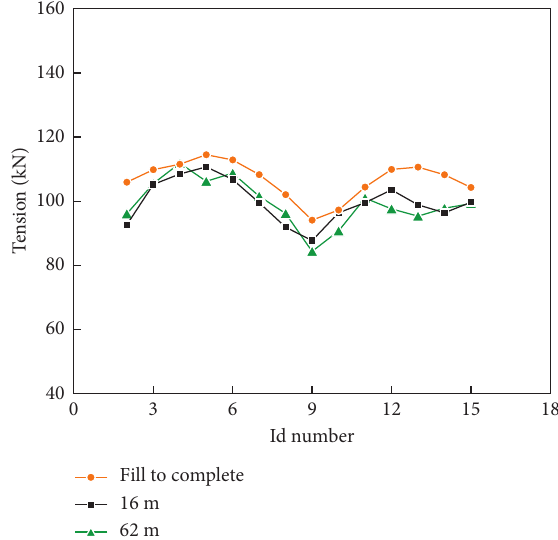
Figure 6: Test curve of the magnetic flux sensor filling test.